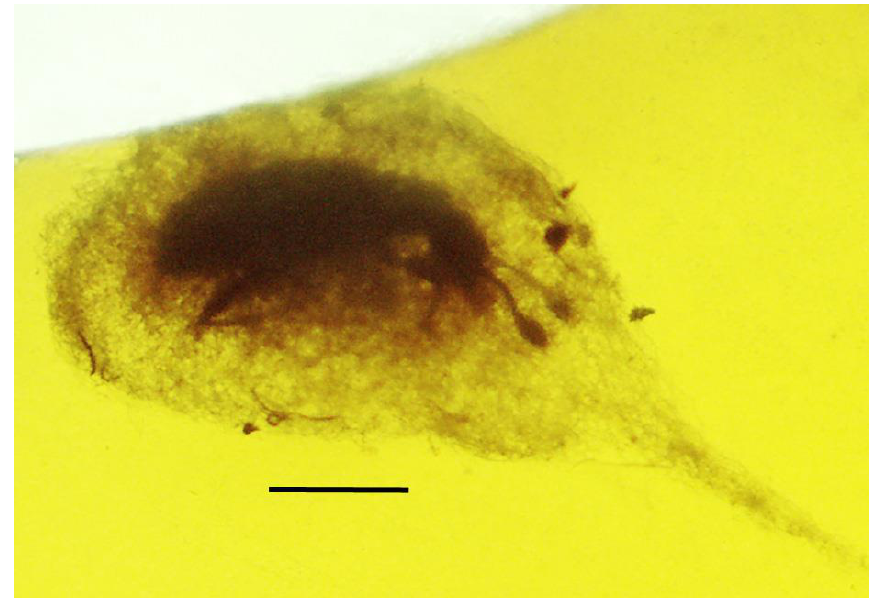
Figure 10. Ant-like stone beetle (Coleoptera: Staphylinidae: Scydmaeninae) wrapped in a spider web “cocoon” in Dominican amber. Scale bar = 1.2 mm.